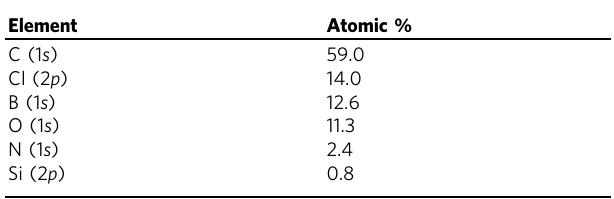
The electron con fi guration that corresponds to the detected signal is given in parentheses